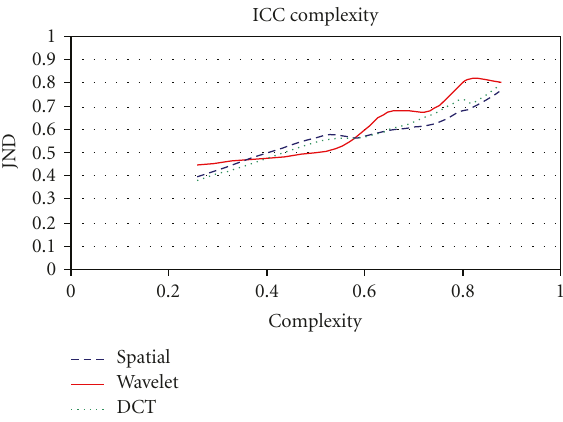
Figure 7: Relation between JND and ICC complexity measure (averaged on 2000 images).